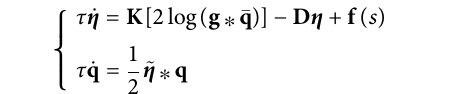
Frontiers in Robotics and AI |